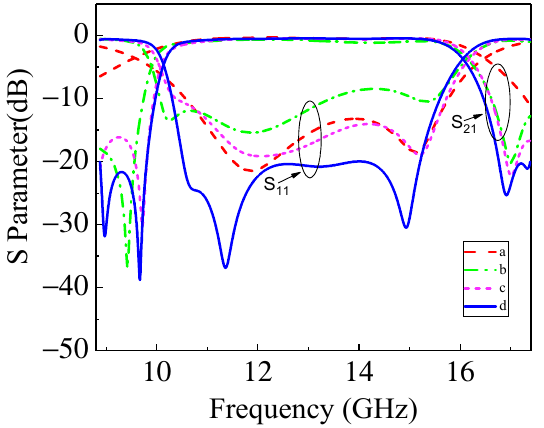
Figure 3. Comparison diagram of simulated reflection and transmission characteristic curves of structural evolution from Figure 2, in which curves (a) correspond to the structure of Figure 2a of two U-shaped microstrip lines; curves (b) correspond to the structure of Figure 2b of loading two groups of open stubs with different lengths on the top layer; curves (c) correspond to the structure of Figure 2c of adding central connecting microstrip; curves (d) correspond to the structure of Figure 2e of the ground layer with DGS.